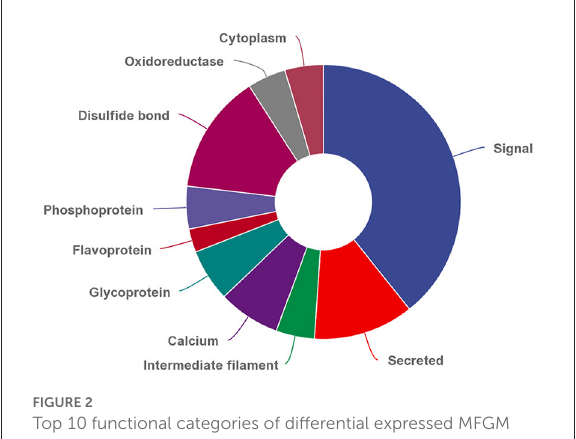
FIGURE2 Top 10 functional categories of differential expressed MFGM proteins based on UP_KEYWORDS (https://david.ncifcrf.gov/